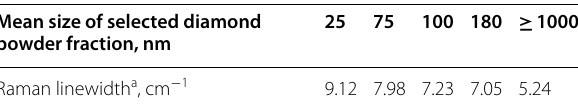
Table 1 The FWHM of the diamond Raman line (at 1331.4 cm − 1 ) for some selected fractions of bead- milled synthetic monocrystalline Ib HPHT diamonds with variable median size Mean size of selected diamond powder fraction, nm